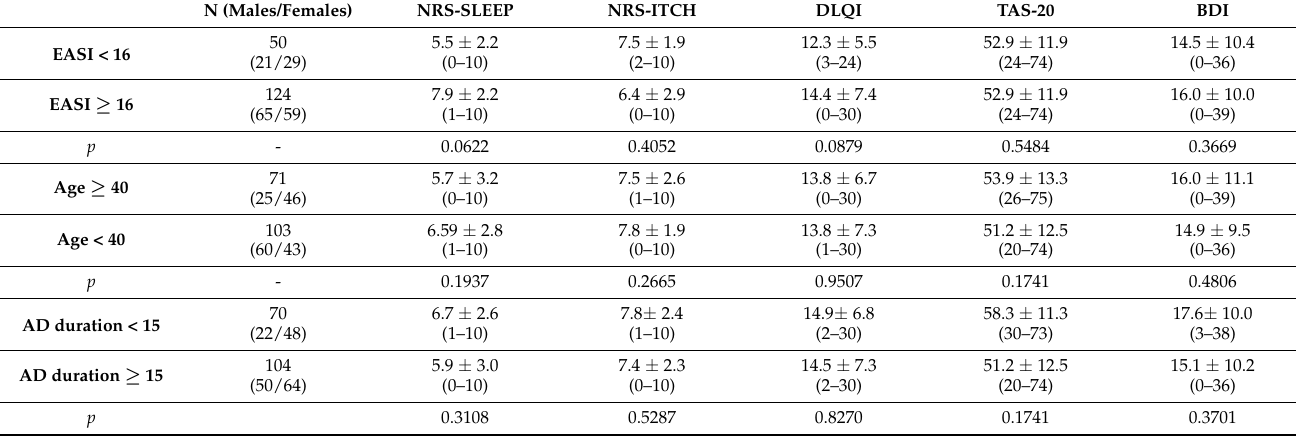
Table 6. Relationship between psychometric assessments and selected clinical